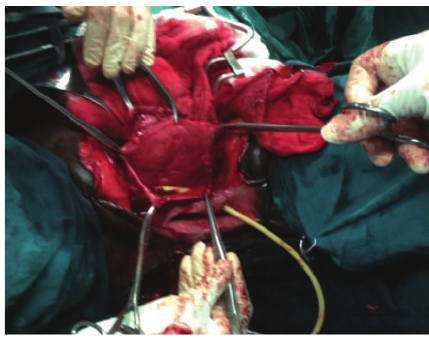
Figure 3: Image showing lacerated bladder edges after reduction of the everted and prolapsed bladder mucosa.